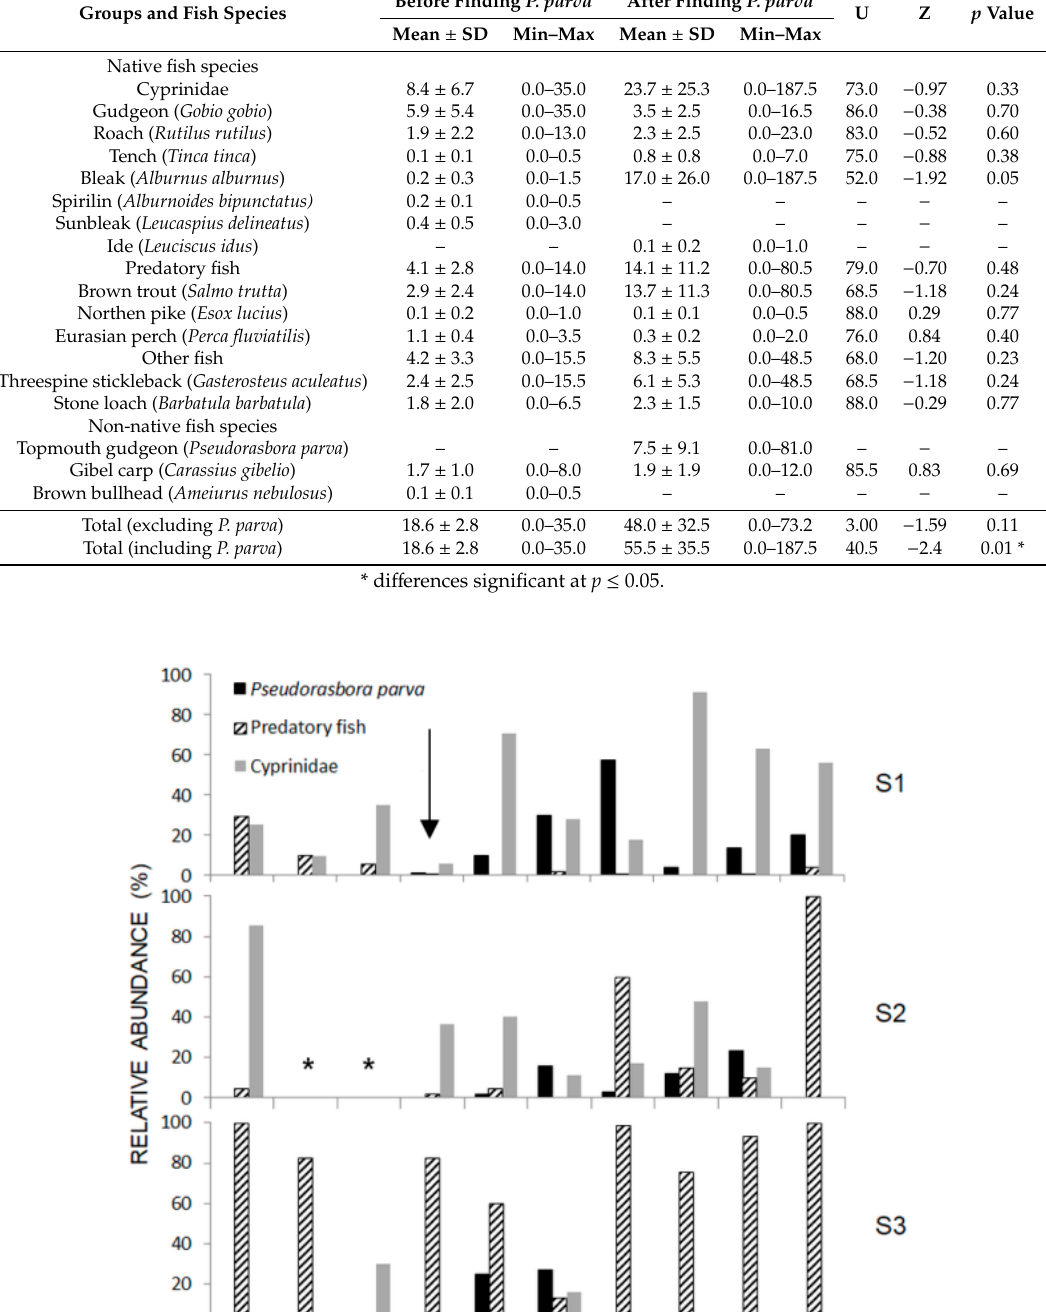
Figure 2. The relative abundance (%) of Cyprinidae, predatory fish and Pseudorasbora parva in the Ciemi˛ega River (sites S1–S3) in 2003–2007, the arrow indicates the time of appearance of Pseudorasbora parva in the Ciemi˛ega river; *—only one species of fish the Stone loach ( Barbatula barbatula ) was noted.